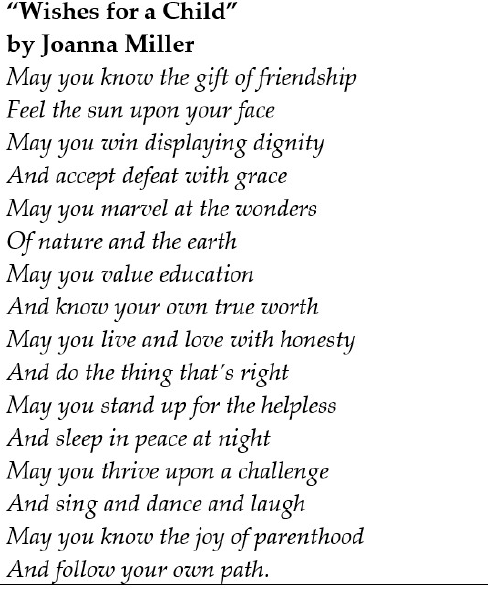
Figure 1. Example of a poem for a humanist naming ceremony.